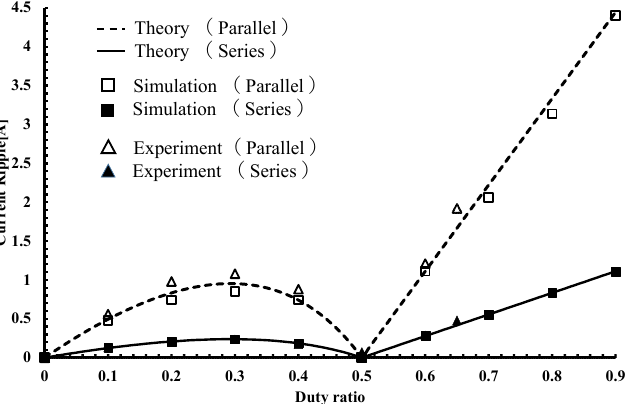
Figure 16. Input current ripple characteristics for duty ratio.